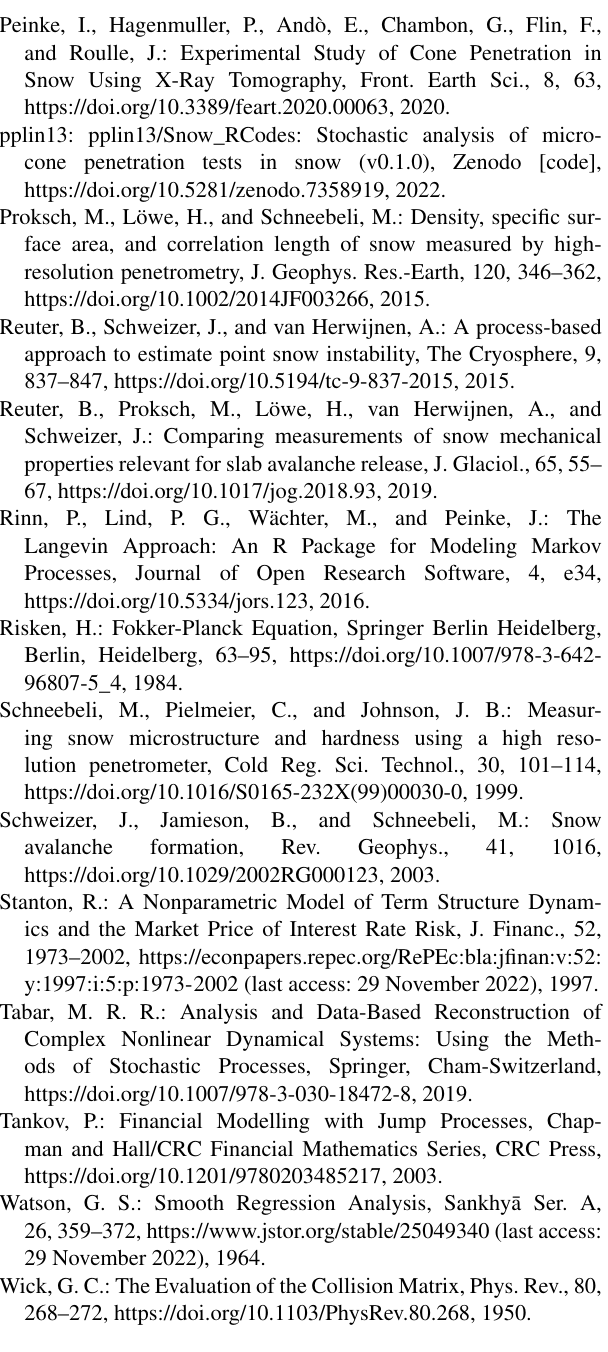
Tabar, M. R. R.: Analysis and Data-Based Reconstruction